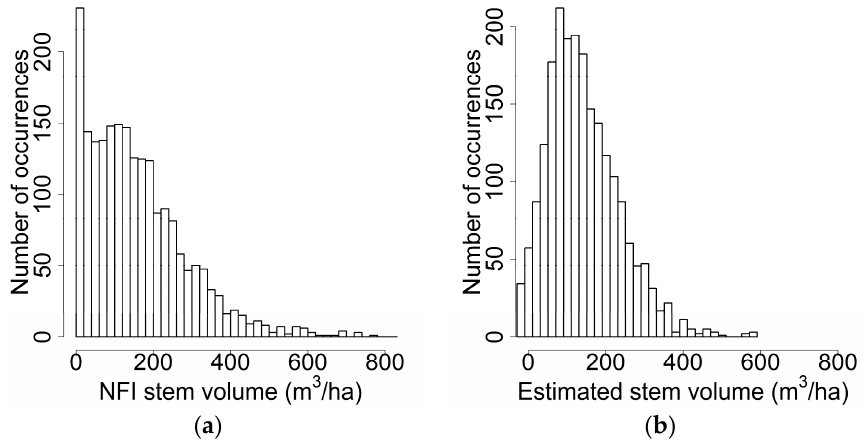
Figure 16. ( a ) The distribution of the field inventoried VOL. ( b ) The distribution of the modelled VOL using TanDEM-X